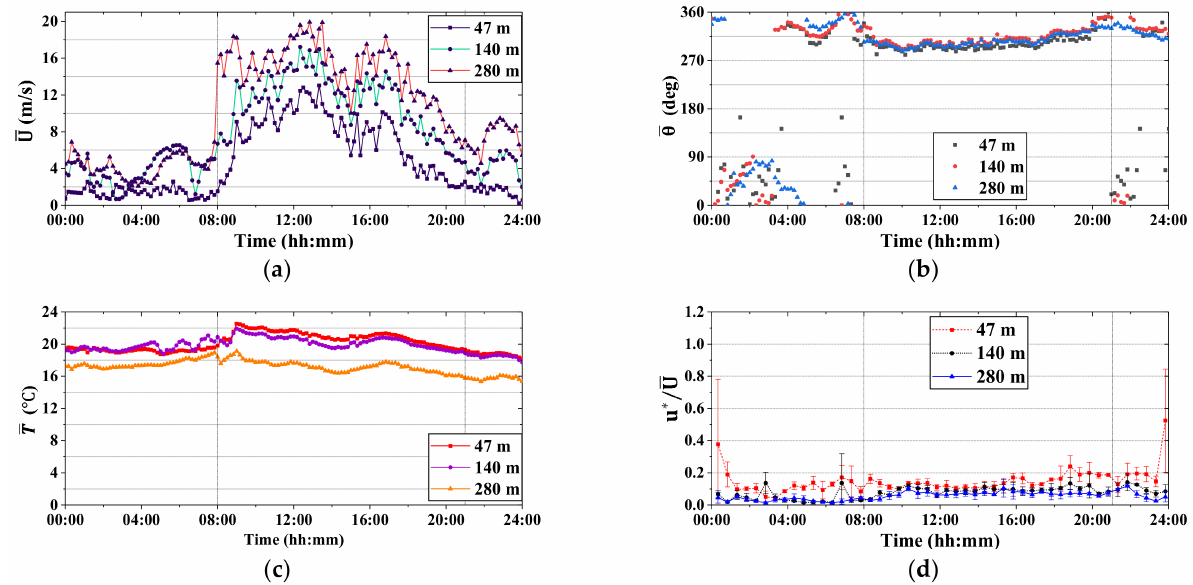
Figure 9. Time histories of the synoptic event which occured on 10 October 2013, related to the heights of 47 m, 140 m and 280 m: ( a ) 10-min mean wind speed, ( b ) 10-min mean wind direction, ( c ) 10-min mean temperature, and ( d ) the friction velocity normalized by the mean wind speed u ∗ / U . The vertical dashed lines include the time window of the event.